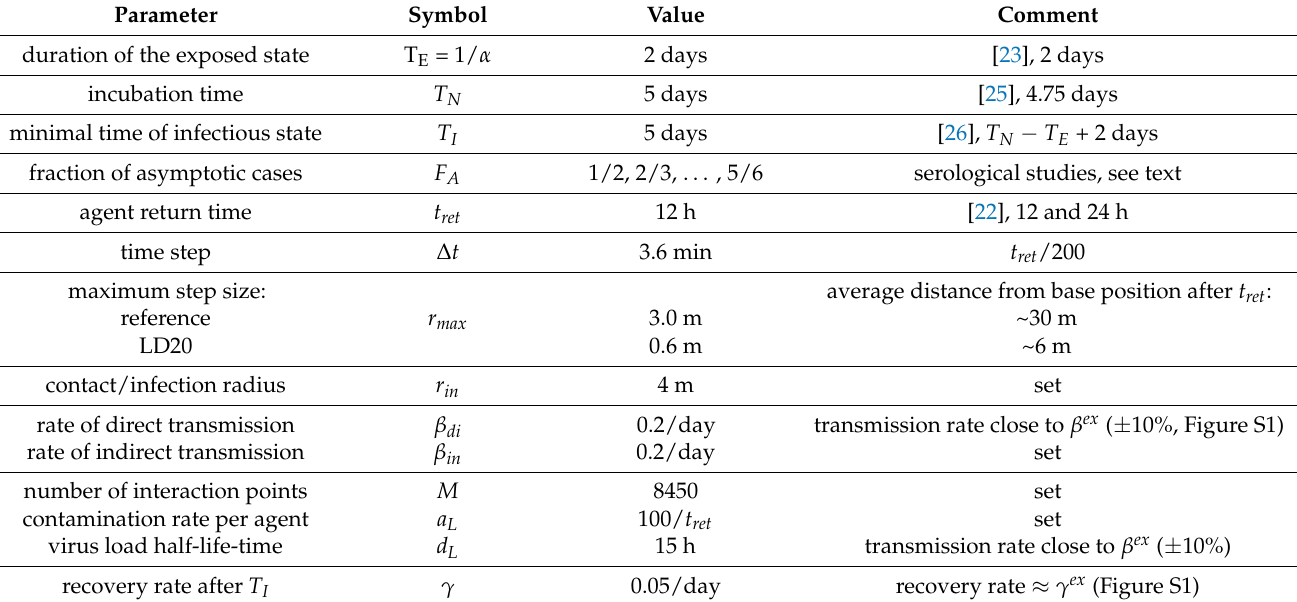
Table 1. Reference model parameter ( N ref ≈ 16,000, A = 1.6 km 2 ). For simplification, we